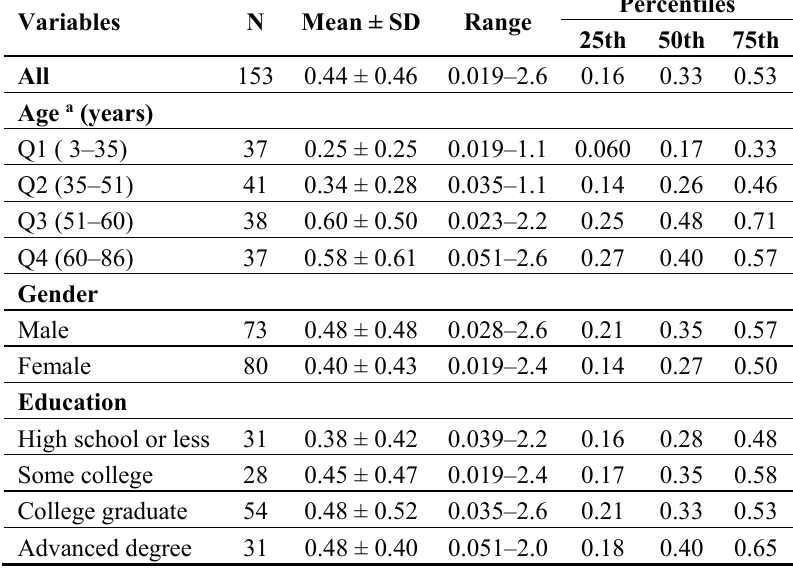
Table 1. Hair Hg levels ( μ g/g) by age, gender, education, body mass index (BMI), smoking status, dust on property, seafood consumption, distance to La Farge, quadrant, 24-h PM 2.5 contour, and housing